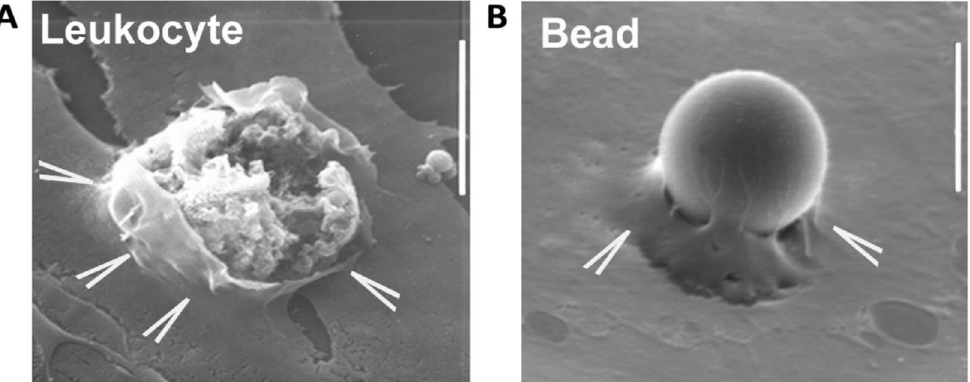
Figure 2. Leukocyte and static bead transmigration. Protrusive membranes (Endothelial protrusions, indicated by the arrowheads) arise from the apical endothelial surface and surround a leukocyte ( A ) or a static bead ( B ). The protrusions are believed to assist the leukocyte on its way through and limit vascular leakage. The image on the left may represent a transcellular event with the leukocyte on its way through the endothelial cell border, although the openings at the endothelial level may also suggest that this is a paracellular event. Scale bar: 10 μ m.